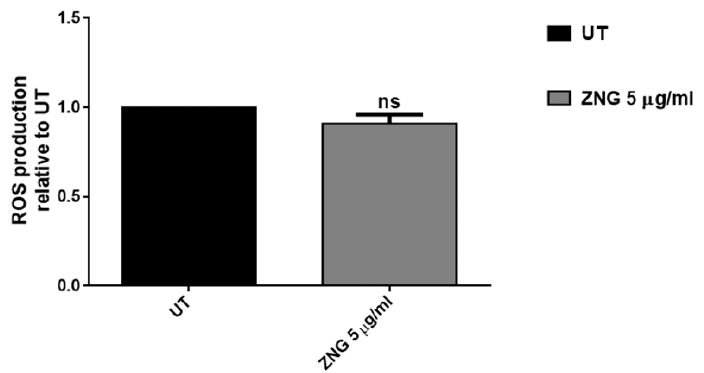
Figure 8. Cytoplasmic reactive oxygen species (ROS) content was evaluated by measuring the dichlorofuorescein diacetate (H 2 DCFDA) probe activation through ROS generation in S. mutans cells treated or not with 5 µg/mL suspensions of ZNGs for 2 h. Data are expressed as fluorescence relative to untreated cells. Statistical analysis was performed by Student’s t -test (ns not significant).